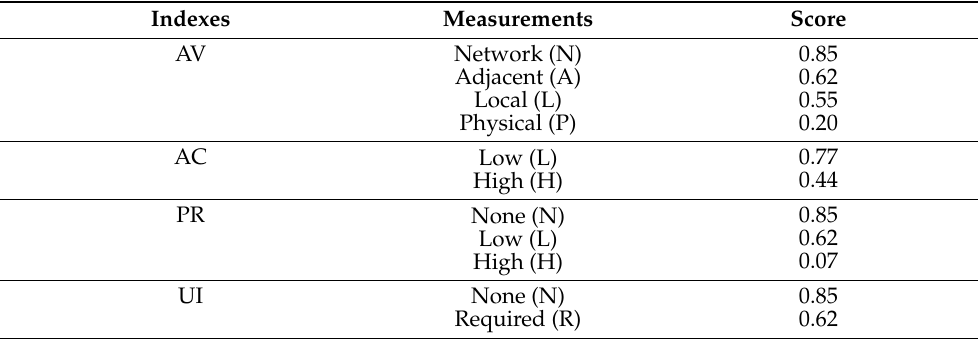
Table 3. CVSS indicator scores used by Luo et al. [65].